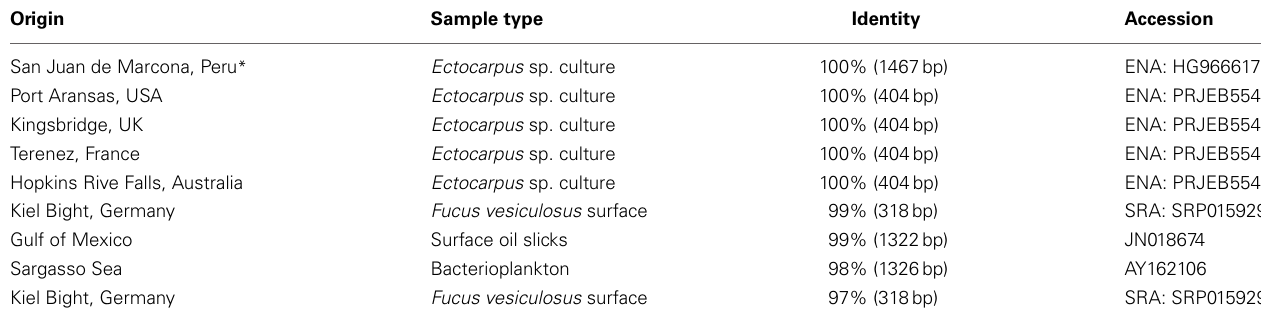
Table 1 | Occurrence of “ Ca. Phaeomarinobacter”-related 16S rDNA sequences ( ≥ 97% identity) in public genomic and metagenomic